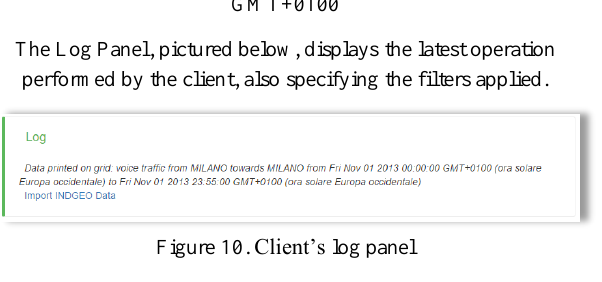
Figure 9. Sensing the city web interface. Data printed on grid: voice traffic from Milano towards Milano from Fri Nov 01 2013 00:00:00 GMT+0100 to Fri Nov 01 2013 23:55:00